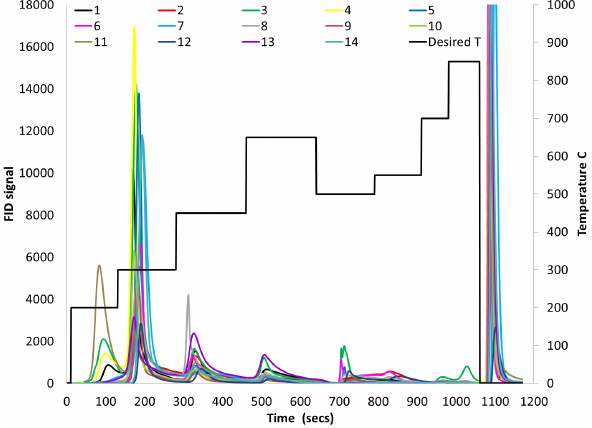
Figure 5. Thermograms of ECOC analysis on standard sucrose so- lution (S2), by EUSAAR2 for all participants.